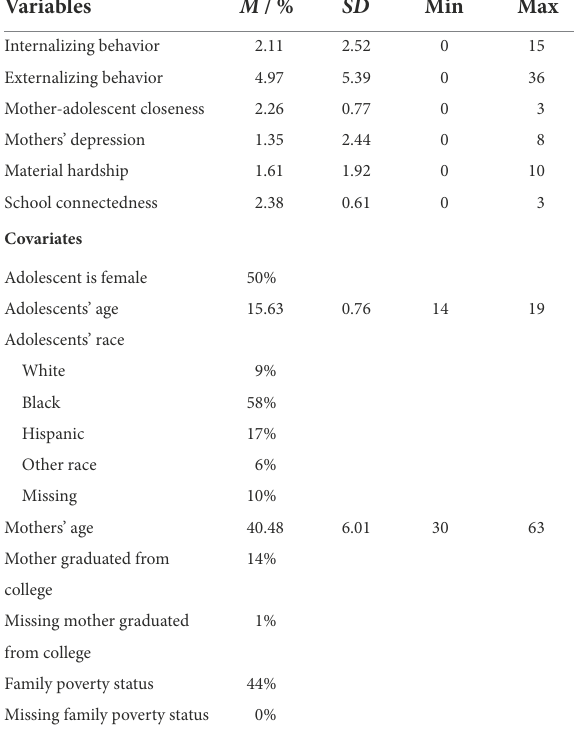
TABLE 1 Summary statistics ( N =